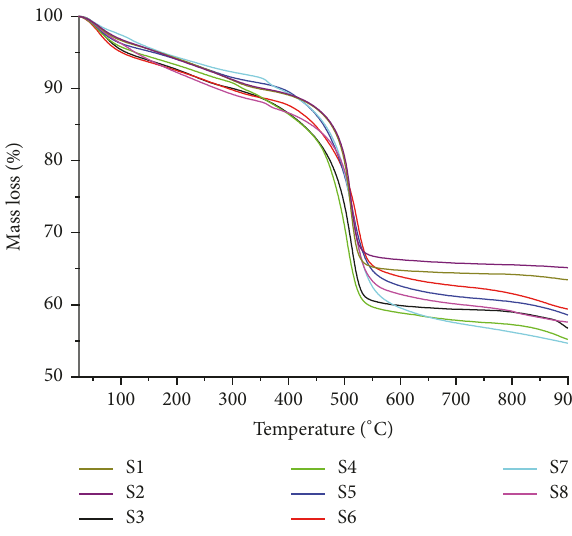
Figure 6: TG data for compounds